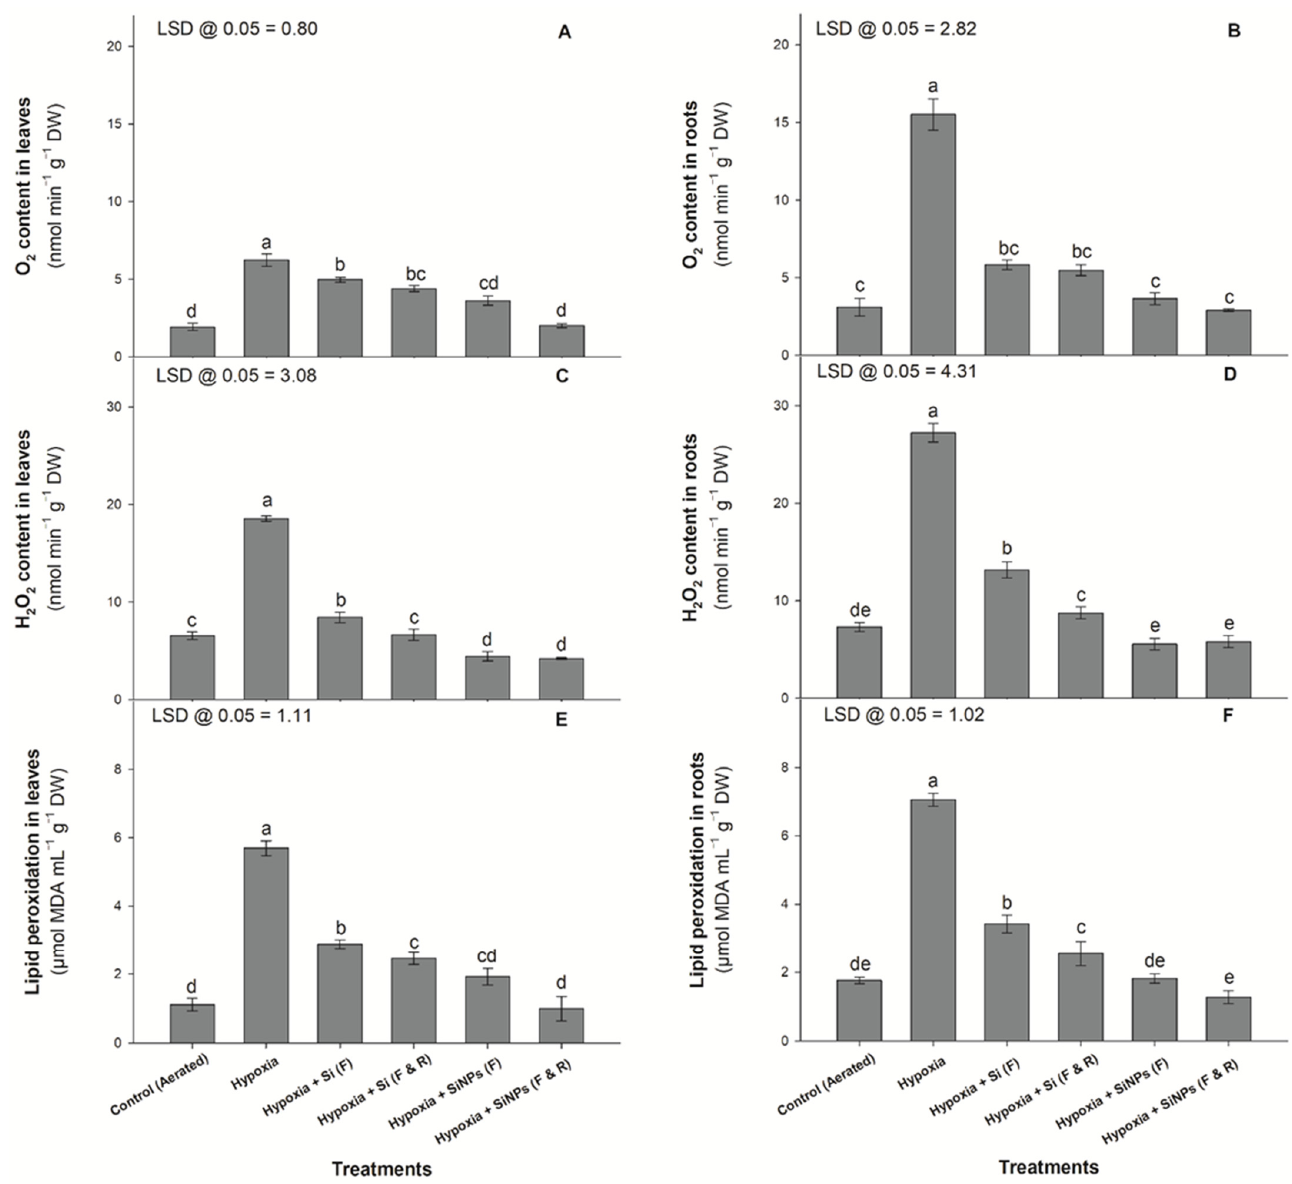
Figure 7. Lipid peroxidation rate ( A , B ), O 2- content ( C , D ), and H 2 O 2 content ( E , F ) in leaves and roots of blueberry plants in response to six treatments i.e., (i) control (aerated), (ii) hypoxia, (iii) hypoxia + Si (F), (iv) hypoxia + Si (F & R), (v) hypoxia + SiNP (F), (vi) hypoxia + SiNPs (F & R). Values are mean of four independent replicates ( n = 4) ± SE (shown in vertical bars), and values denoted by different letters (in small alphabets) differ significantly at p < 0.05, using the LSD test. The abbreviations used are F: foliar application of Si or SiNP; F & R: combined foliar and root zone application of Si; H 2 O 2 : hydrogen peroxide; O 2 -: free radicals of oxygen oxide; R: root zone application of Si or SiNP; Si: conventional silicon; SiNPs: silicon nanoparticles.